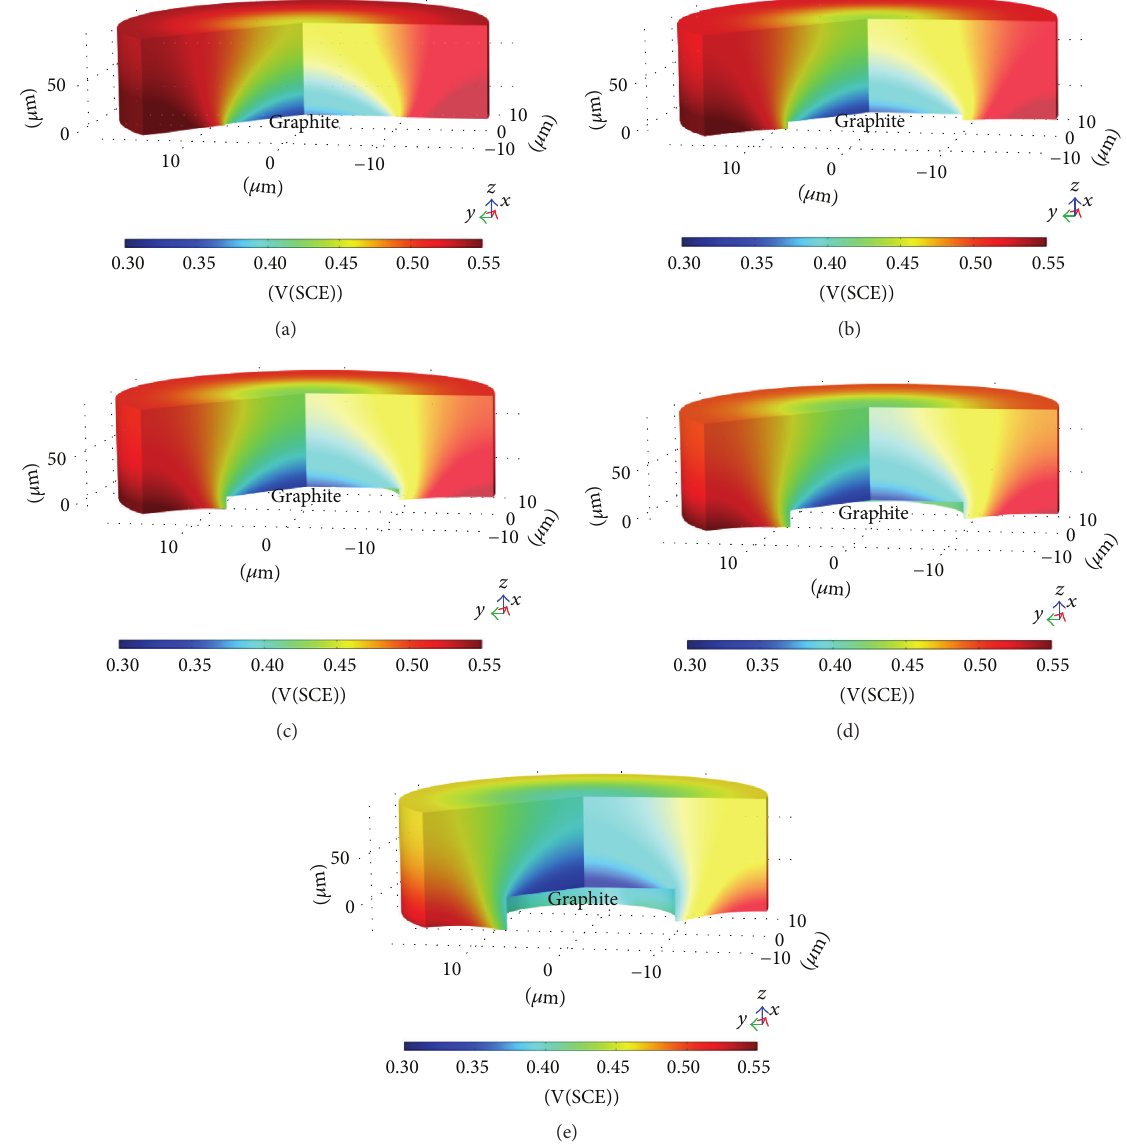
Figure 9: Surface electrolyte potential (V(SCE), the right vertical color bar) obtained by computer 3D simulation (the unit of 𝑥 -, 𝑦 -, and 𝑧 -axes; 𝜇 m) using COSOL Multiphysics on corrosion propagation with immersion time of ductile cast iron occurred in stagnant simulated cooling water (10,000 ppm NaNO 2 ) at 25 ∘ C; (a) 0 hour, (b) 24 hours, (c) 48 hours, (d) 72 hours, and (e) 144